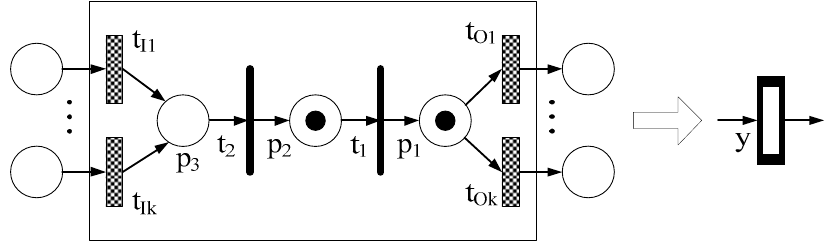
Figure 4. The PN model for the pipeline.